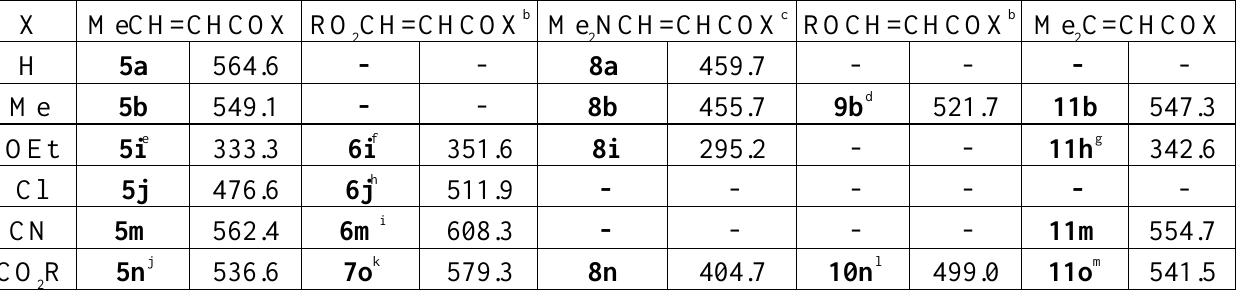
Table 2. 17 O NMR chemical shifts of 5 - 11 (solvent MeCN at 40°C) a